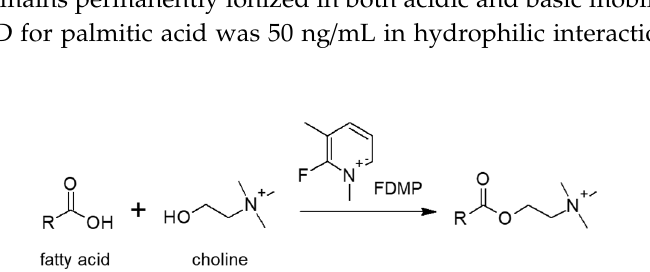
Figure 3. Reaction scheme of fatty acids labeling with choline facilitated by 2-fluoro-1,3-dimethyl- pyridinium (FDMP).